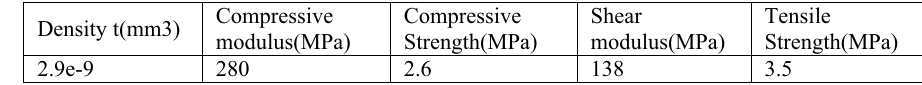
Table 2. The properties of aramid papers.